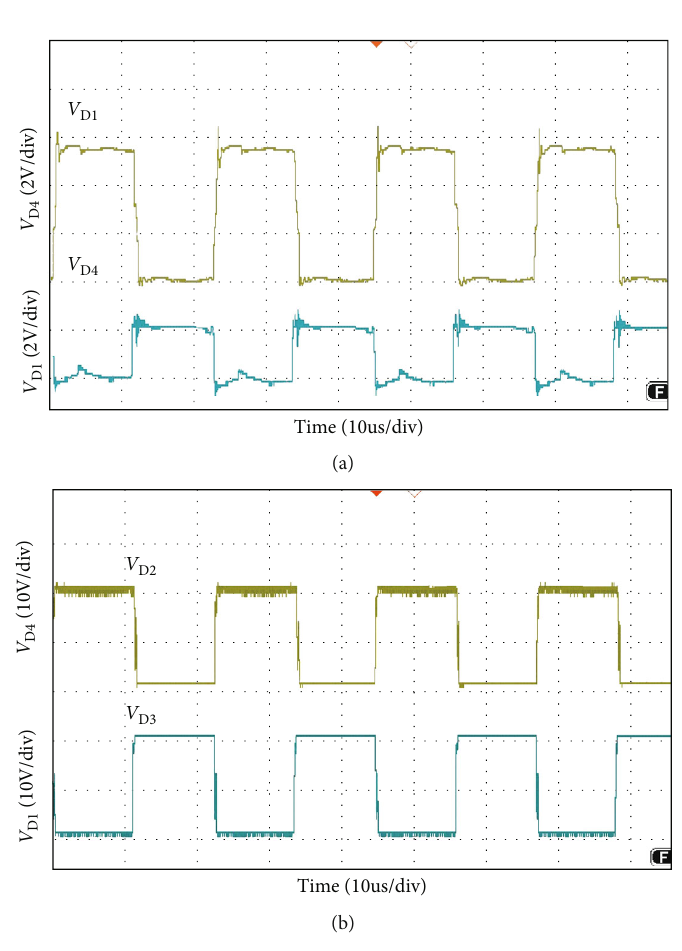
Figure 17: Diode voltage stress